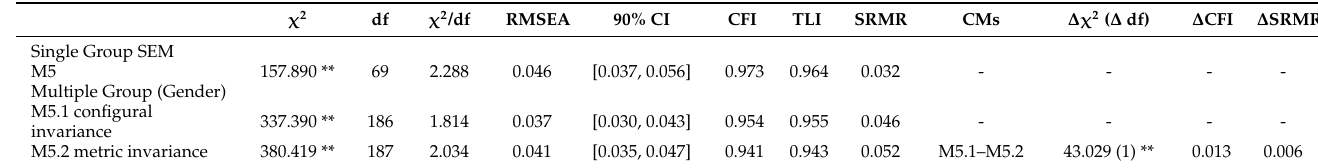
Table 4. Fit indexes for single group and multi-group SEM Model